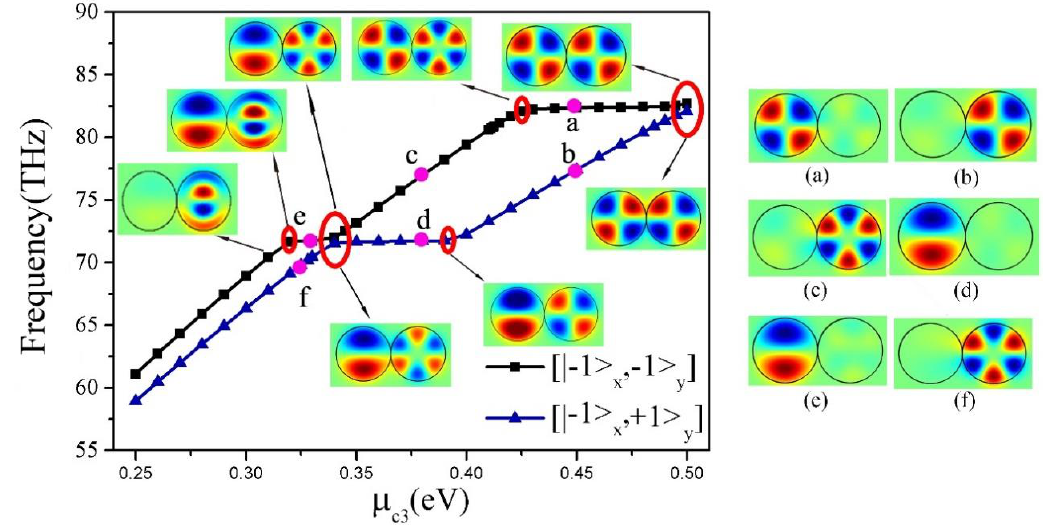
Figure 7. The frequencies of [| − 1> x ,| − 1> y ] and [| − 1> x ,|+1> y ] modes as a function of the chemical potential μ c3 .